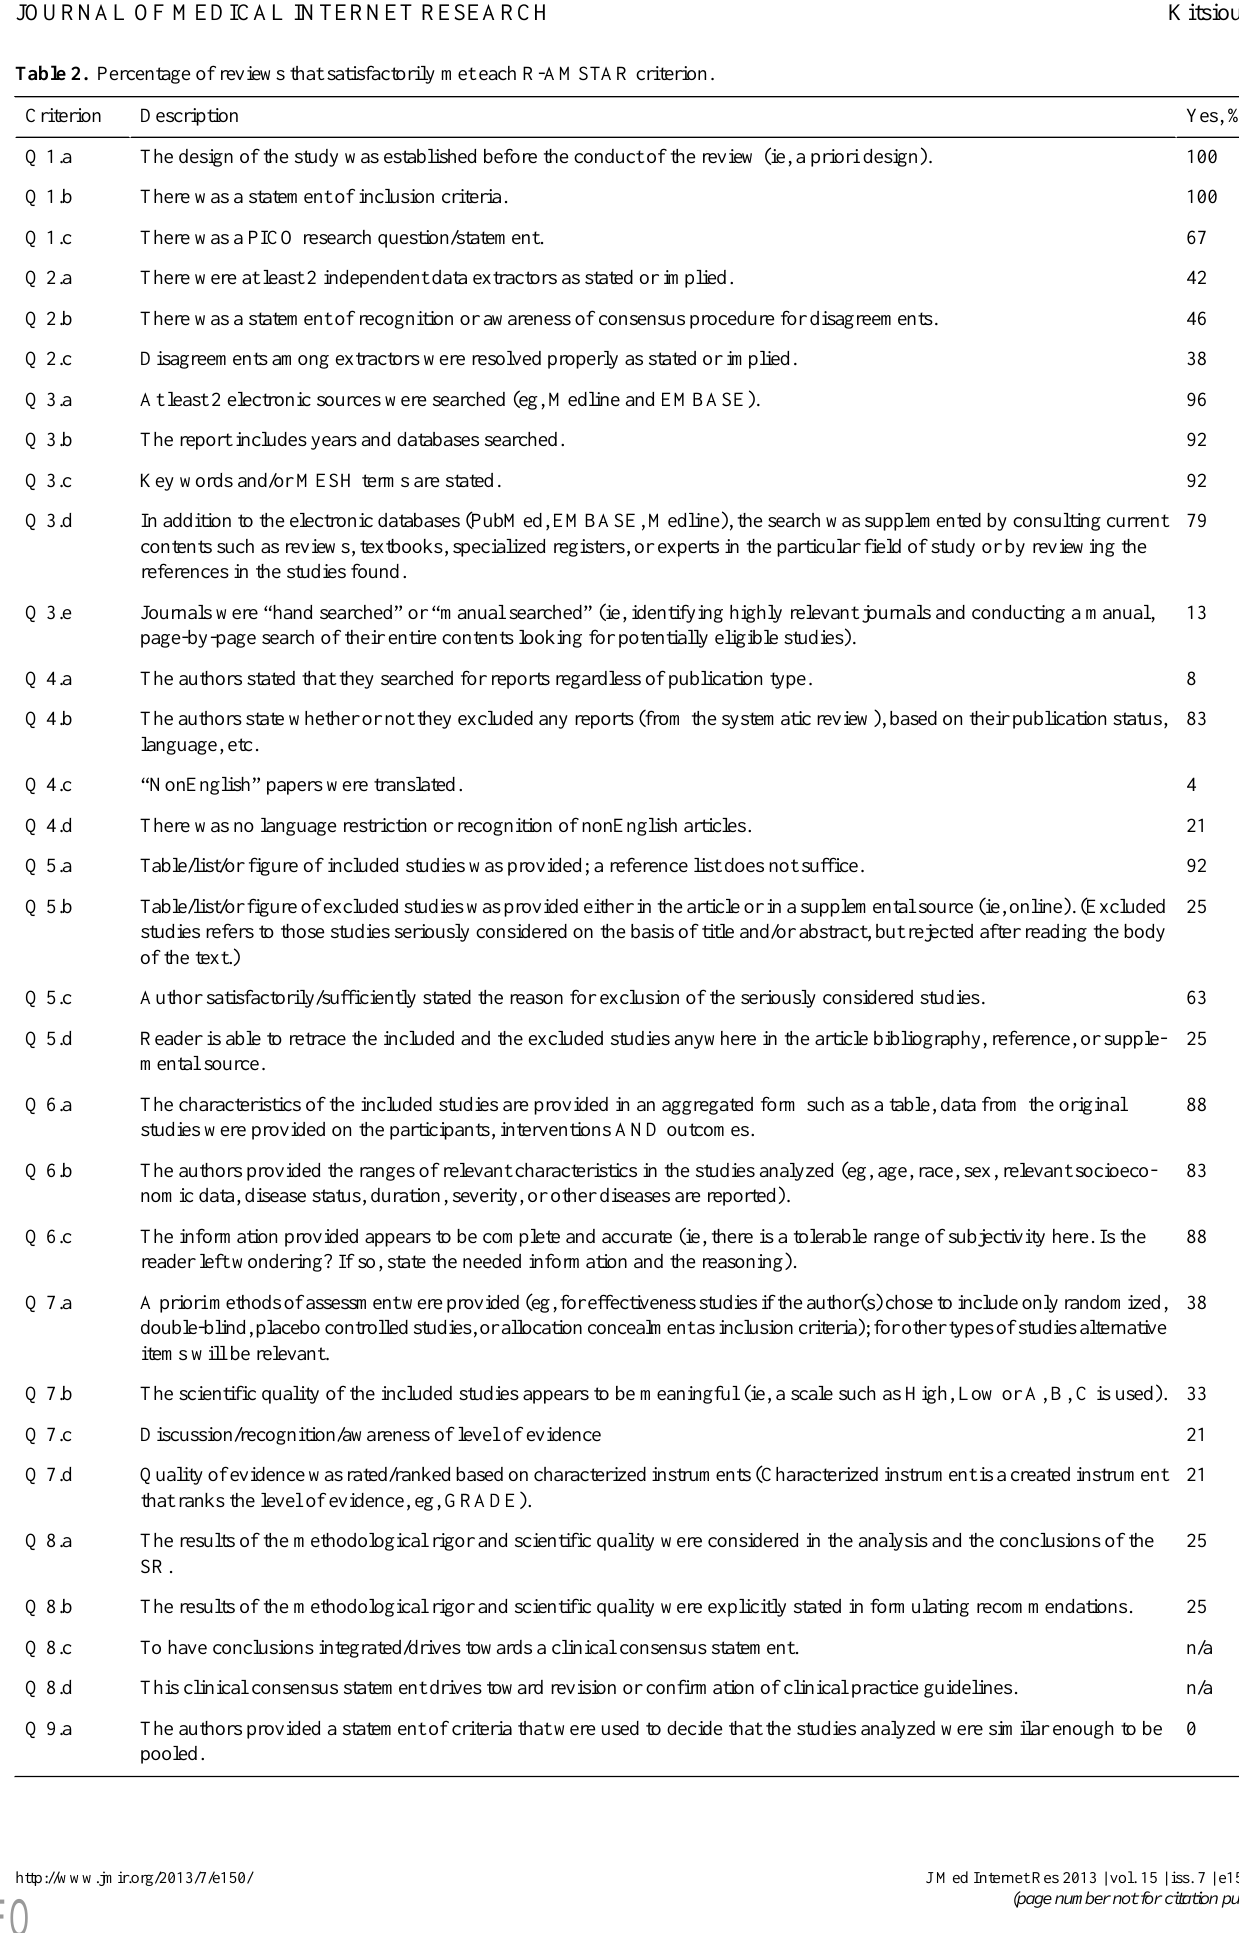
Table 2. Percentage of reviews that satisfactorily met each R-AMSTAR criterion.